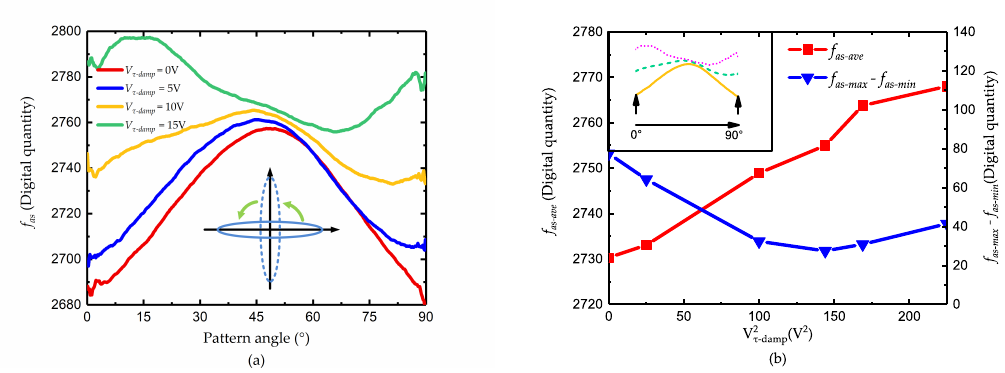
Figure 8. Damping mismatch tuning ( a ) the value of f as and ( b ) the value of f as − ave and f as − max − f as − min . Consistent with the conclusion in Section 3, the voltages at 0 ◦ and 90 ◦ do not change the angle of damping axis but reduce the mismatch of the two axis. As the tuning effect, the curve of f as only moves upward and the peak-to-peak value gradually declines. However, when the voltage is larger than 13 V, the peak-to-peak value of f as begins to increase, which indicates that the tuning is overdone and the relationship between f as and θ is revised. As shown in Figure 9a, the tendency of the curve V τ − damp = 15 V is just opposite to other